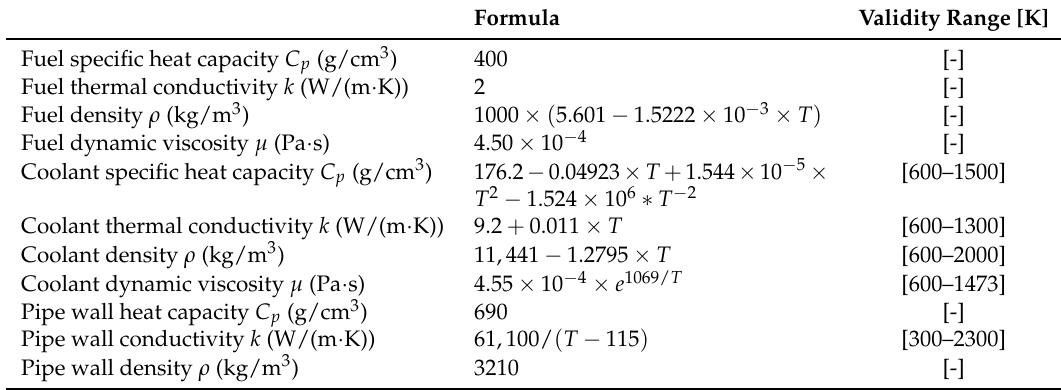
Table 2. Thermophysical properties of the two fluids and wall